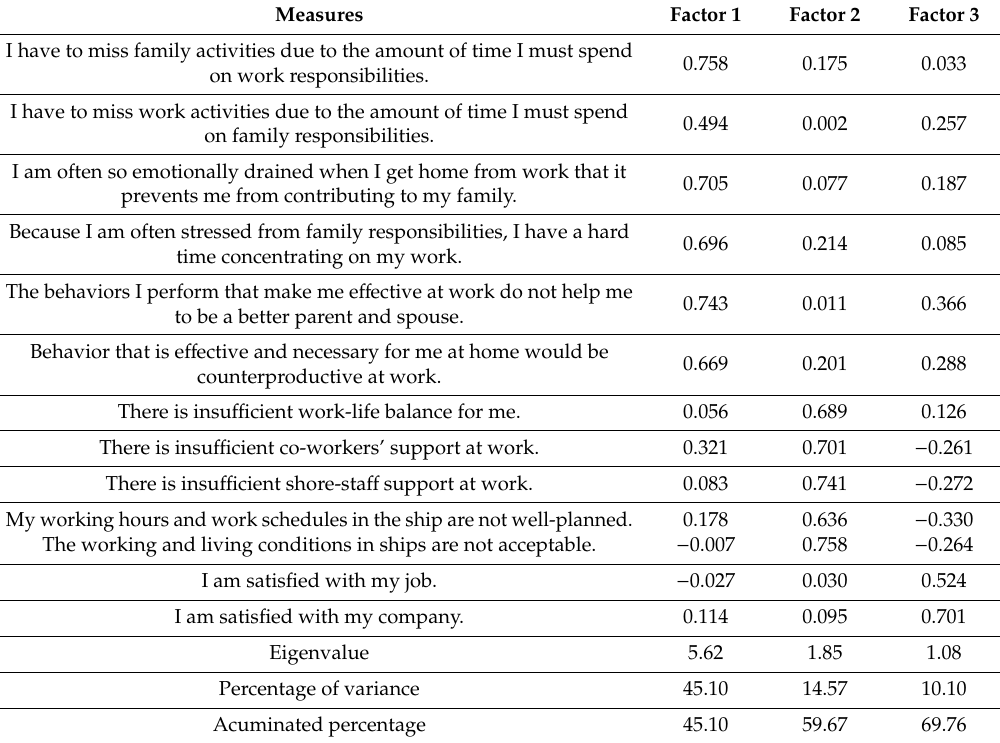
Table 3. Exploratory factor analysis